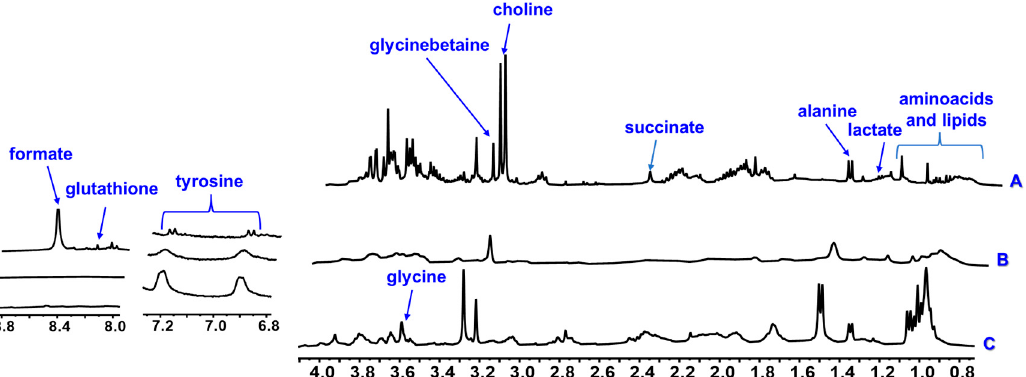
Figure 2. 1 H HR-MAS NMR spectra (400 MHz, D 2 O) of the microalgae N. oceanica (A), C. muelleri (B), and C. weissflogii (C). In blue, the metabolites identified are indicated.